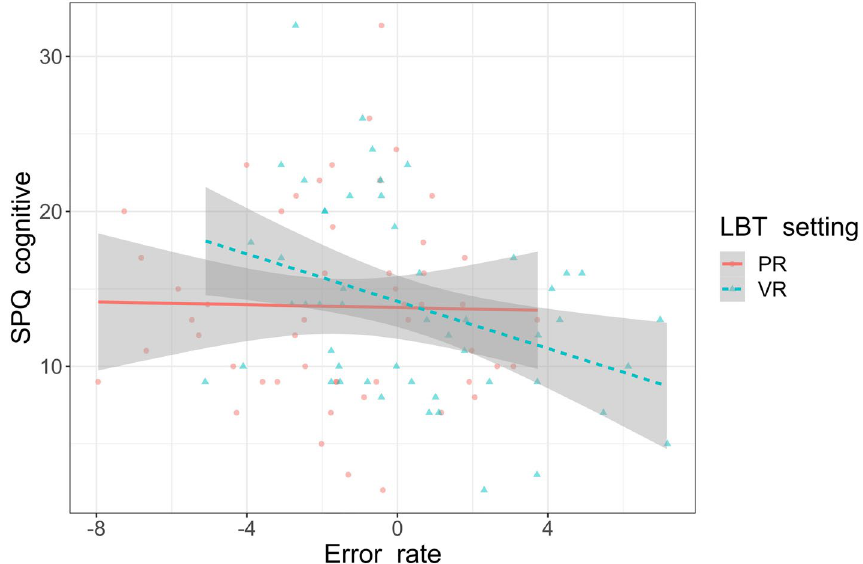
Figure 3. The association between LBT error rates in PR (continuous line) and VR (dashed line) settings and SPQ cognitive. The “0” indicates the centre of the test line. Negative scores indicate leftward LBT error bias and positive cores indicate rightward LBT error